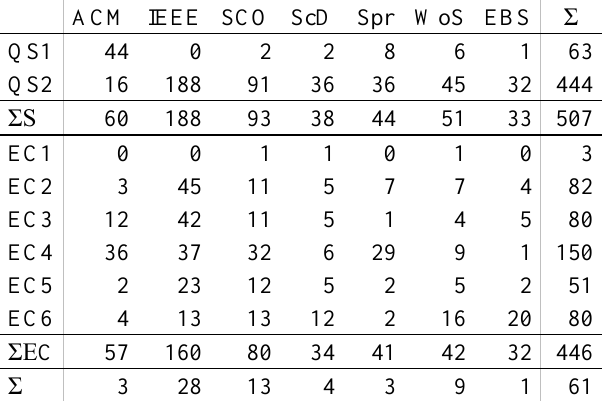
Table 2. Application of the Research Protocol. Source: The authors.